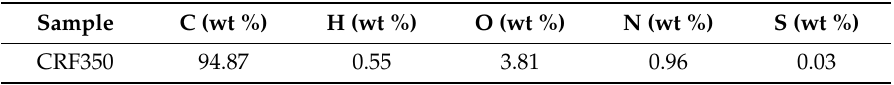
Table 1. Elemental analysis of one representative cellular carbon monolith sample: CRF350.